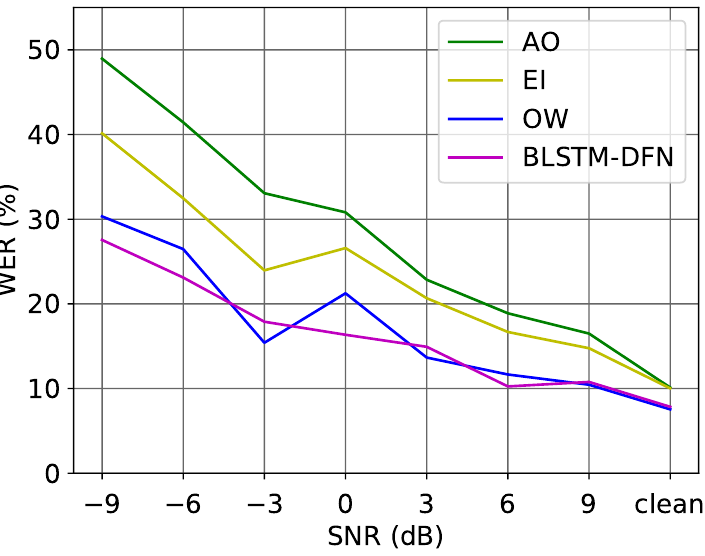
Figure 8. Estimated log-posteriors of sentence S2 for the target state s ∗ All abbreviations are the same as in Table 3. The whiskers show the maximum and minimum values; the upper and lower bounds of the green blocks represent the respective 25th and 75th percentile; the yellow line in the center of the green block indicates the median.